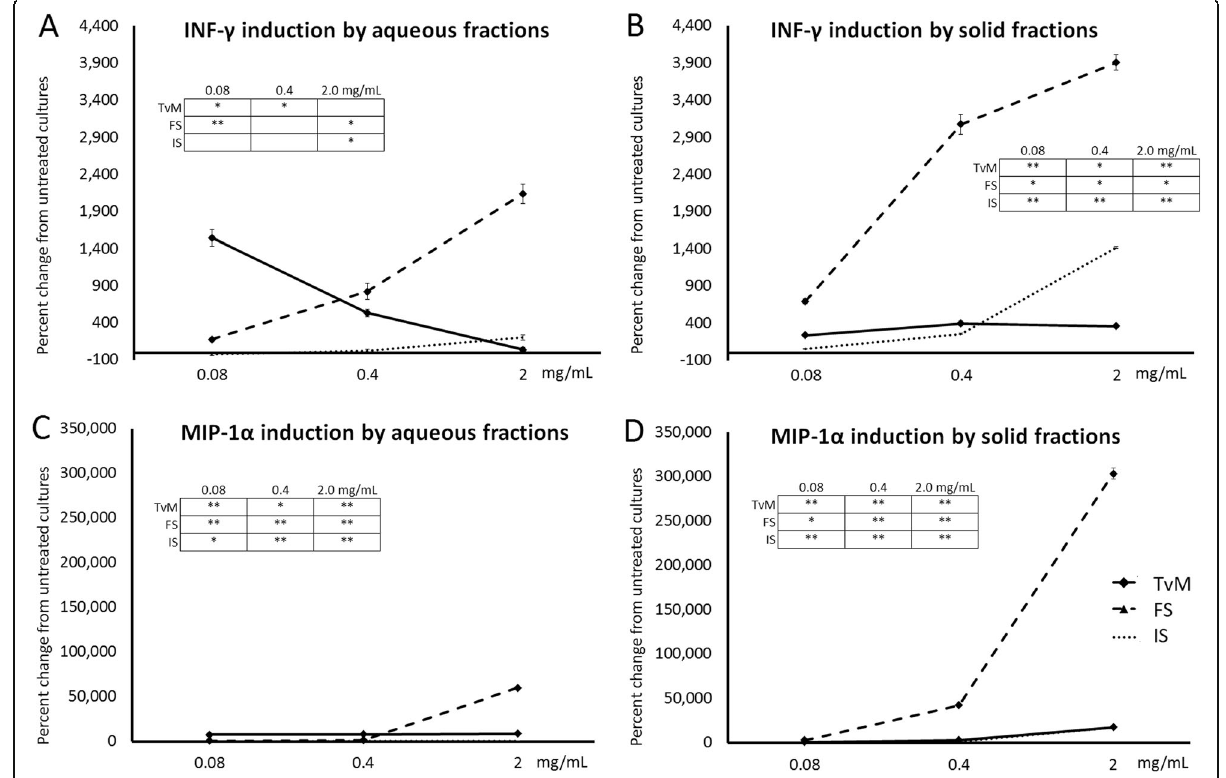
Fig. 6 Changes in levels of the cytokines Interferon-gamma (IFN- γ ) and Macrophage Inflammatory Protein-1-alpha (MIP-1 α ) in supernatants from human PBMC cultures. The PBMC were cultured for 24 h in the presence of serial dilutions of Trametes versicolor mycelium (TvM), fermented substrate (FS), or initial substrate (IS). The effects on IFN- γ and MIP-1 α , cytokines involved in anti-viral immune defense activity, of aqueous extracts shown in A and C, and of the solid fractions are shown in B and D. Data are shown for three doses (0.08, 0.4, and 2 mg/mL), where the doses represent the amount of starting material used to produce a given fraction. Data are presented as mean ± standard deviation of the percent change seen in triplicate cultures, and represents one of three separate experiments using PBMC cells from three different healthy human donors. Inserted tables: Statistical significance is indicated as * for P < 0.05 and ** for P <